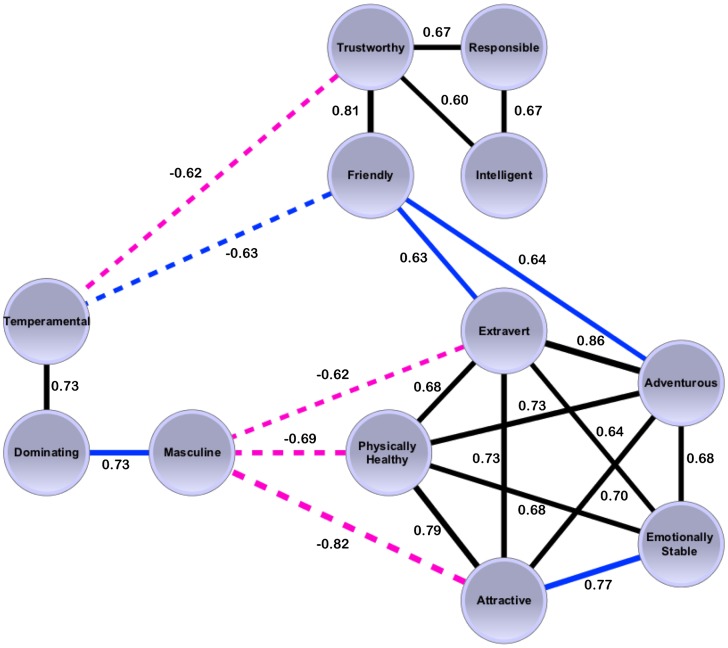
Network graph of all significant correlations between Ratings.The network depicts the relationship between the individual Ratings as the correlation coefficient, r, between scores. A dashed line depicts negative and a solid line positive correlations and the thickness of the line indicates the strength of the relationship with r as the edge label. Relationships significant for both genders are black, for men blue and for women magenta. Three clusters can be seen in the network with Trustworthy, Responsible, Friendly and Intelligent in the first, Extraverted, Adventurous, Emotionally Stable, Attractive and Physically Healthy in the second and Temperamental, Dominating and Masculine in the third. We named the clusters trustworthiness-friendliness, attractiveness-health-extraversion and dominance-masculinity.